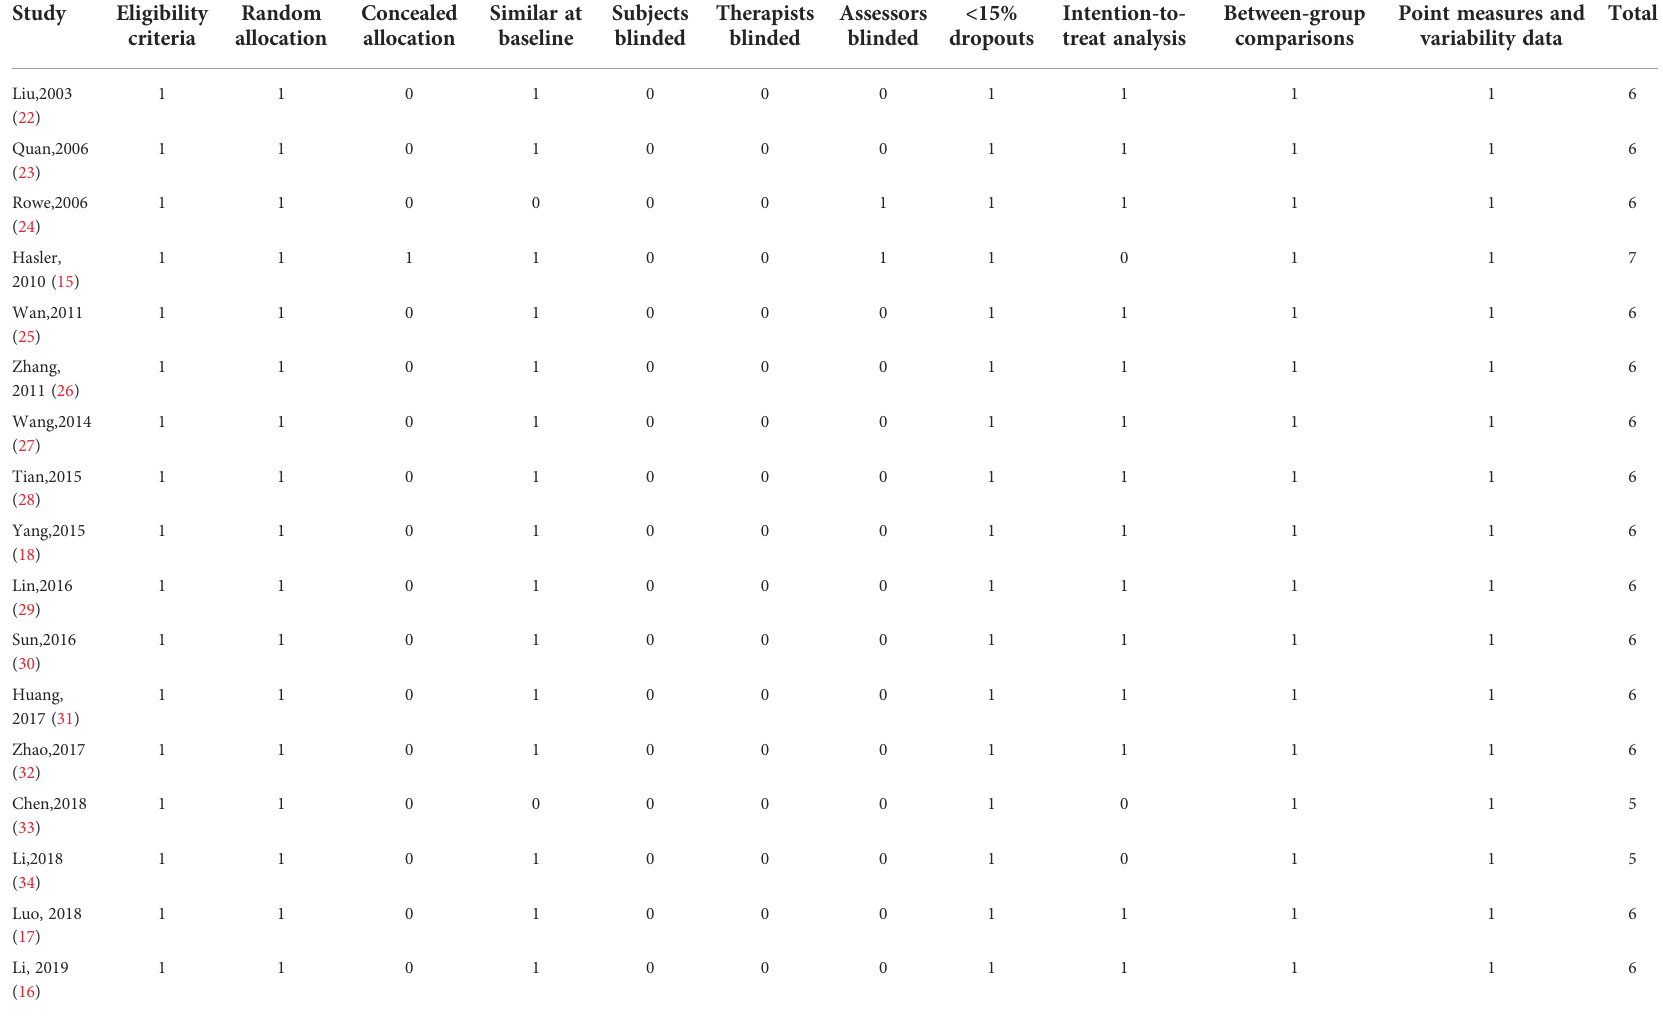
TABLE 2 PEDro scale of quality for the included